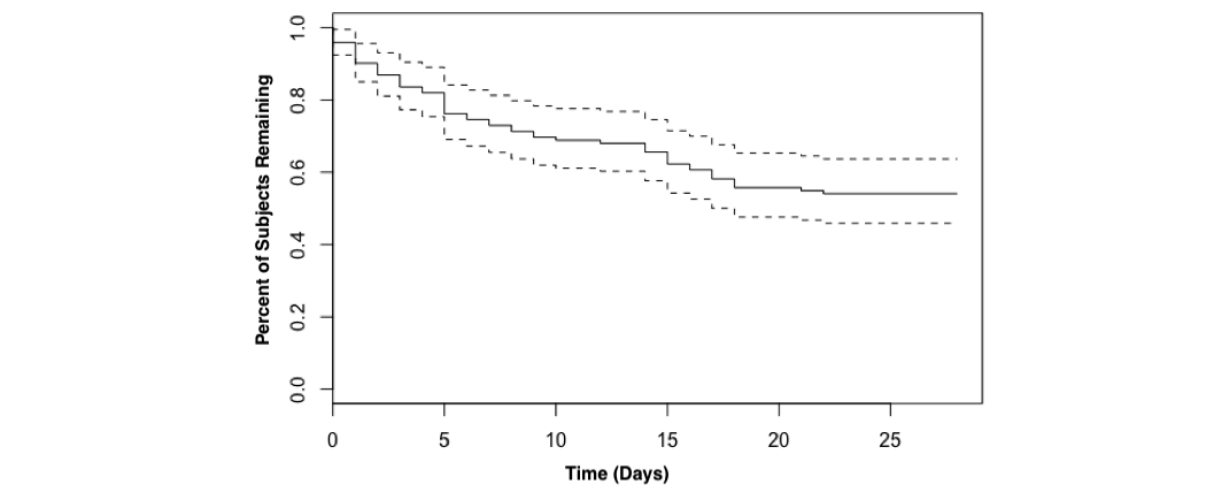
Figure 4. “Survival” of Coach app participants as shown by a Kaplan-Meier survival curve with 95% confidence intervals (dashed lines).